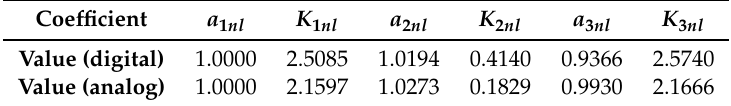
Table 3. Values of the coefficients for the nonlinear regression in Equations